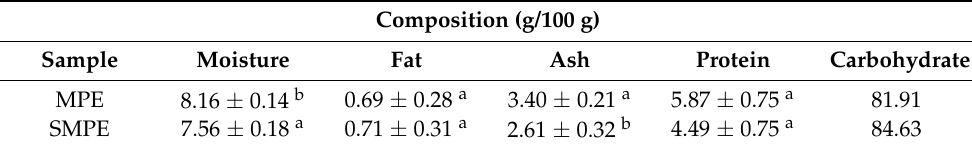
Table 7. Proximal composition of umbu peels flours.